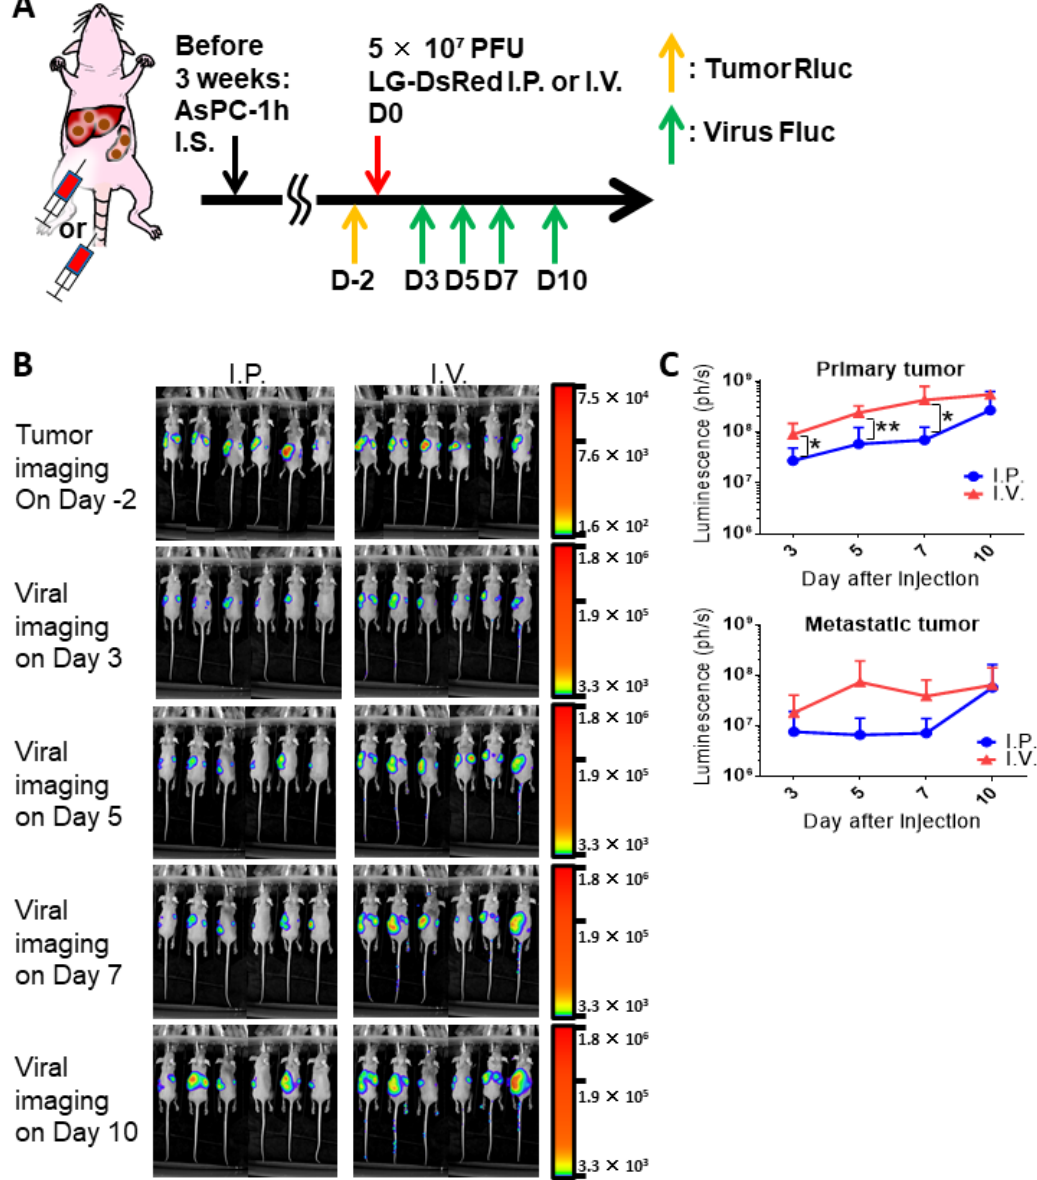
Figure 5. Comparison of intraperitoneal (I.P.) or intravenous (I.V.) injections of mitogen-activated protein kinase-dependent recombinant vaccinia virus (MDRVV) (LG-DsRed) in a mouse model harboring liver metastasis caused by human pancreatic ductal adenocarcinoma cells. ( A ) Schematic representation of the study design and timeline of tumor growth and viral distribution. ( B ) AsPC-1 CD44v9-high cells expressing Renilla Luciferase (Rluc; AsPC-1h) were injected intrasplenically into athymic nude mice and liver metastasis was detected via tumor Rluc luminescence on day 2 before viral treatment. Mice were injected intraperitoneally or intravenously with 5 × 10 7 PFU of MDRVV (LG-DsRed). Viral replication was detected on days 3, 5, 7, and 10 via firefly luciferase (Fluc) luminescence. ( C ) Quantification of viral Fluc luminescence in primary splenic and metastatic liver sites was determined from ( B ). The data are presented as the mean ± SD (n = 6). * p < 0.05, ** p < 0.01 (two-tailed unpaired t -test).